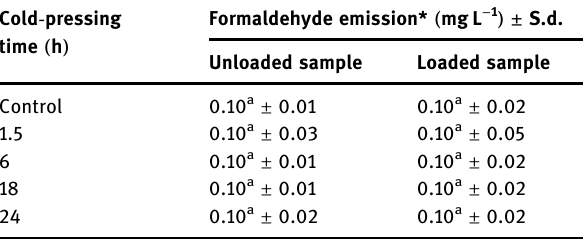
Table 17: Average value of formaldehyde emission Cold - pressing Formaldehyde emission* ( mg L − 1 ) ± S.d. time ( h )